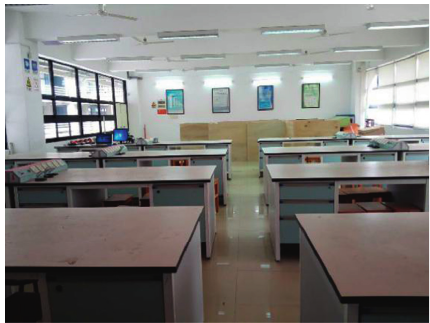
Figure 11: Lab office environment.